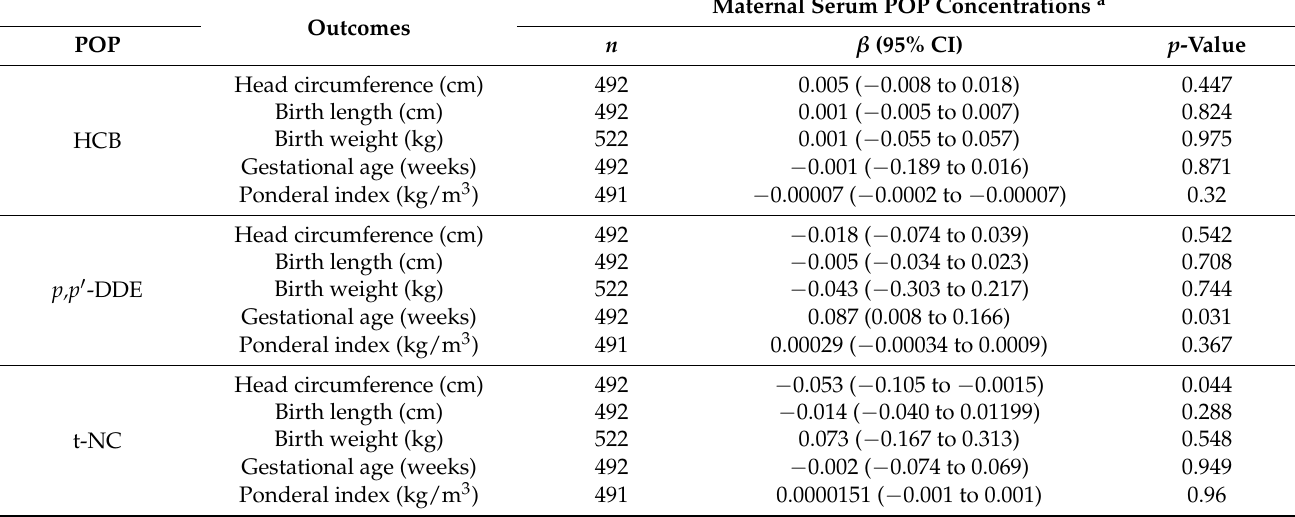
Table 4. Results of linear regression analysis measuring associations between maternal serum POP concentrations on birth